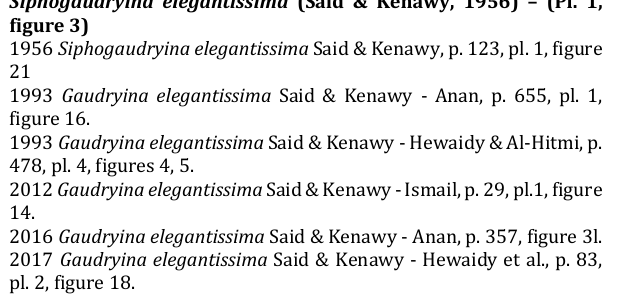
Holotype: Illustrated specimen in Pl. 1, figure 6 x 44. Dimension: Length 34 mm, width 15 mm. Etymology: In the honor of Pakistanian micropaleontologist A.F.M. Mohsenul Haque. Type locality: Khairabad Limestone, Pakistan. Age: